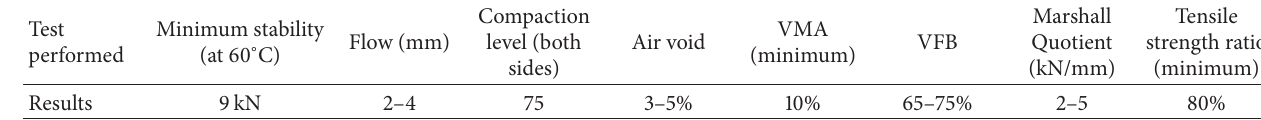
Table 6: Design criteria as per MoRT&H.